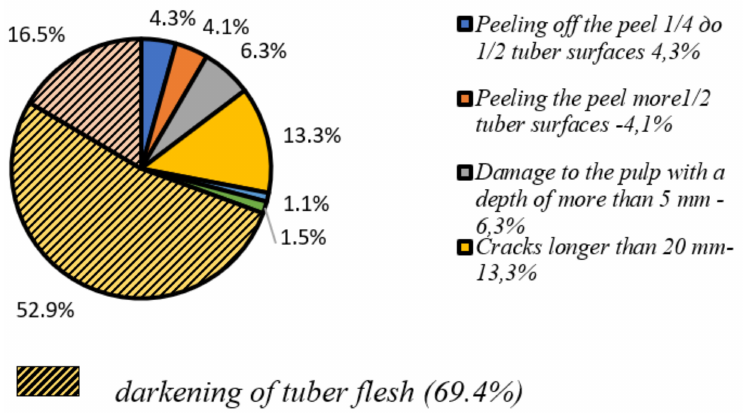
Figure 4. The structure of tuber damage during harvester potato pickup as percentage of the total number of damages.